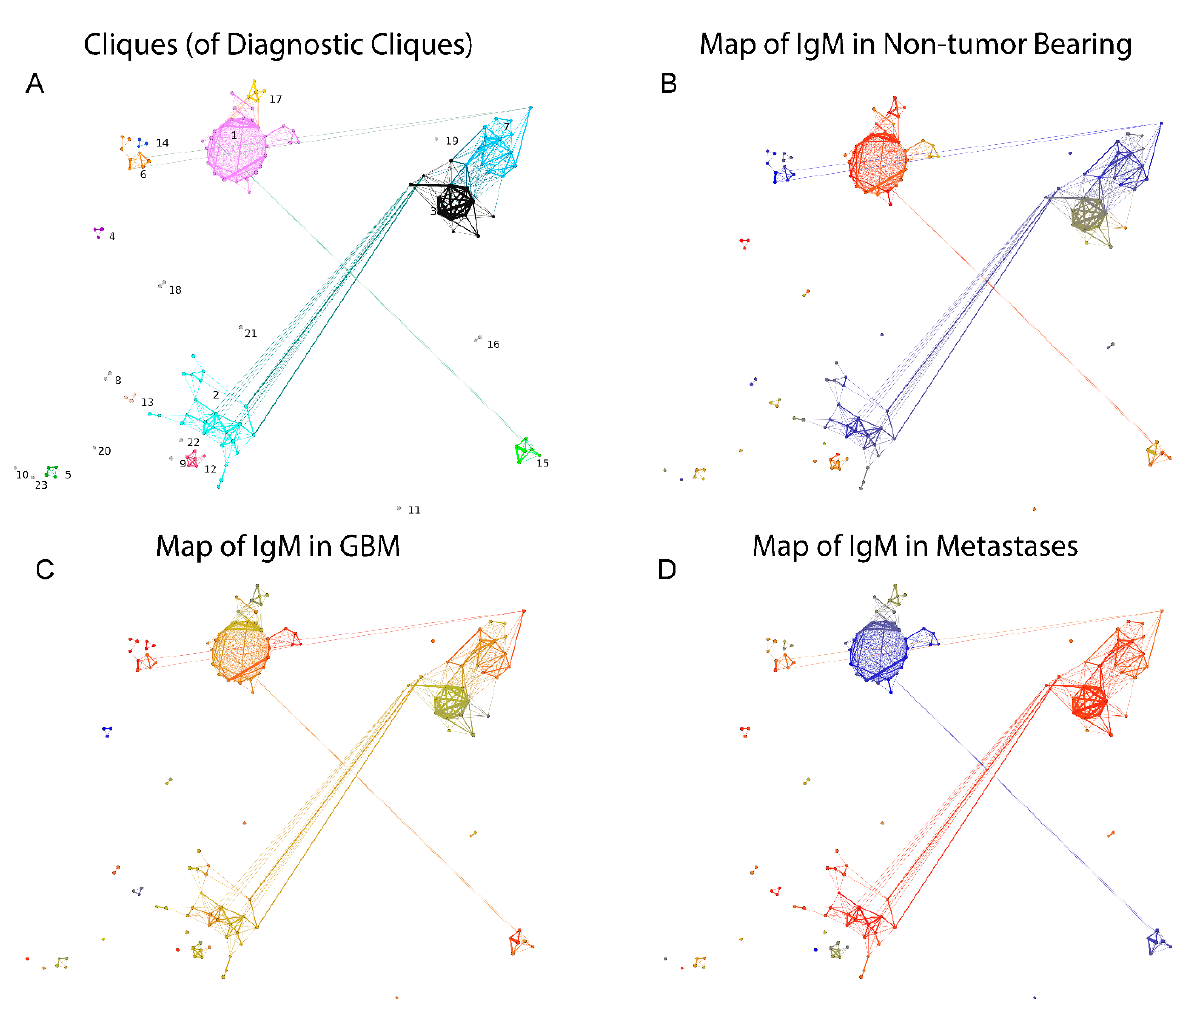
Figure 11. The graph of DClq (GpCl). Each vertex is a clique in the reactivity graph, and the edges correspond to the existence of common vertices between the connected cliques with the size of the overlap encoded in the edge weights. The layout follows roughly the map of the reactivity graph. ( A ) Louvain clustering yielded 23 clusters of GpCl. ( B ) Map of the reactivities over (red)/under (blue) expressed in non-tumor bearing patients. ( C ) Map of the reactivities over (red)/under (blue) expressed in GBM patients. ( D ) Map of the reactivities over (red)/under (blue) expressed in brain metastasis patients.